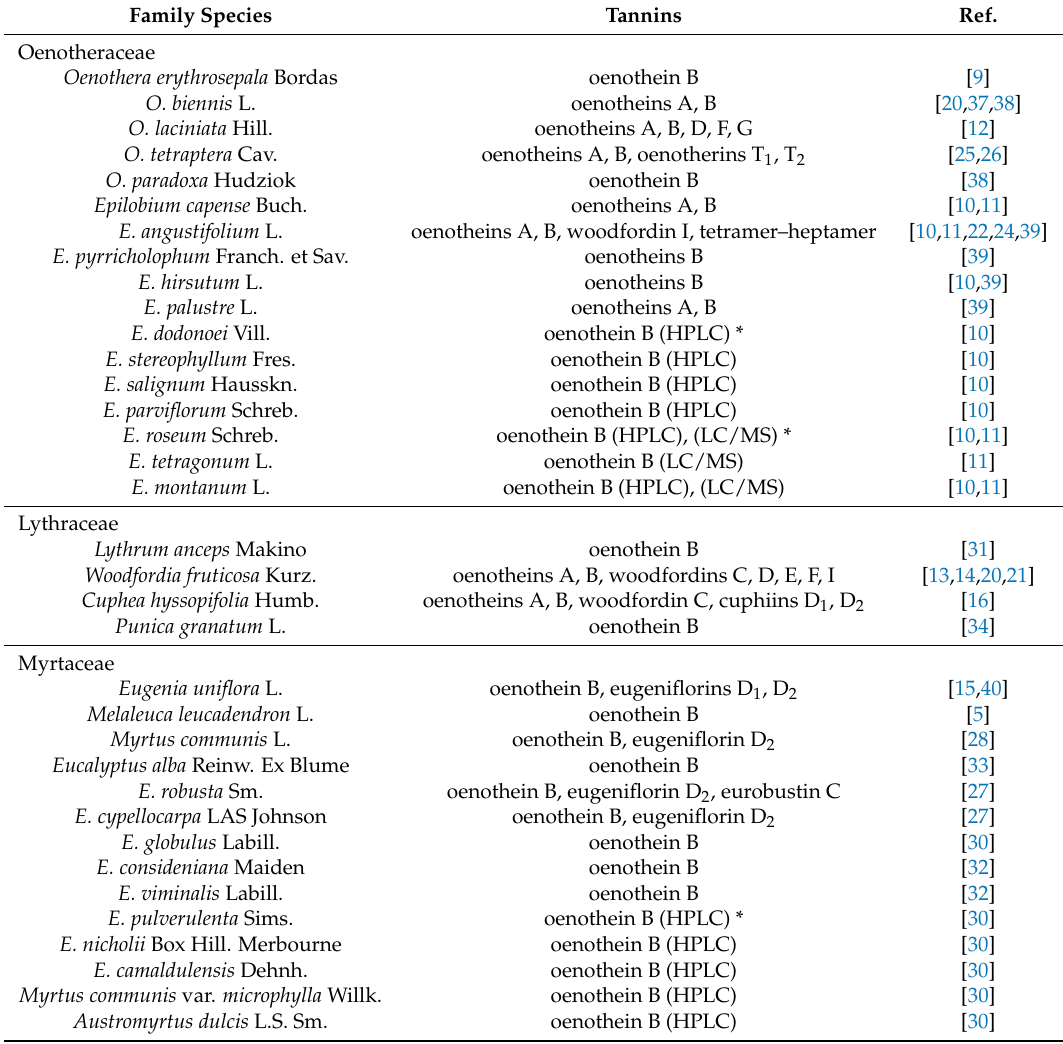
Table 1. Distribution of oenothein B and related macrocyclic oligomers in plants. Family Species Tannins